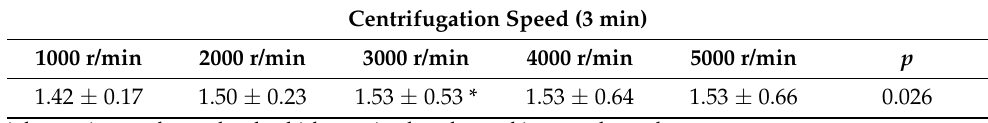
Table 3. Effect of centrifugal speed on salivary glucose. (Unit: mmol/L).